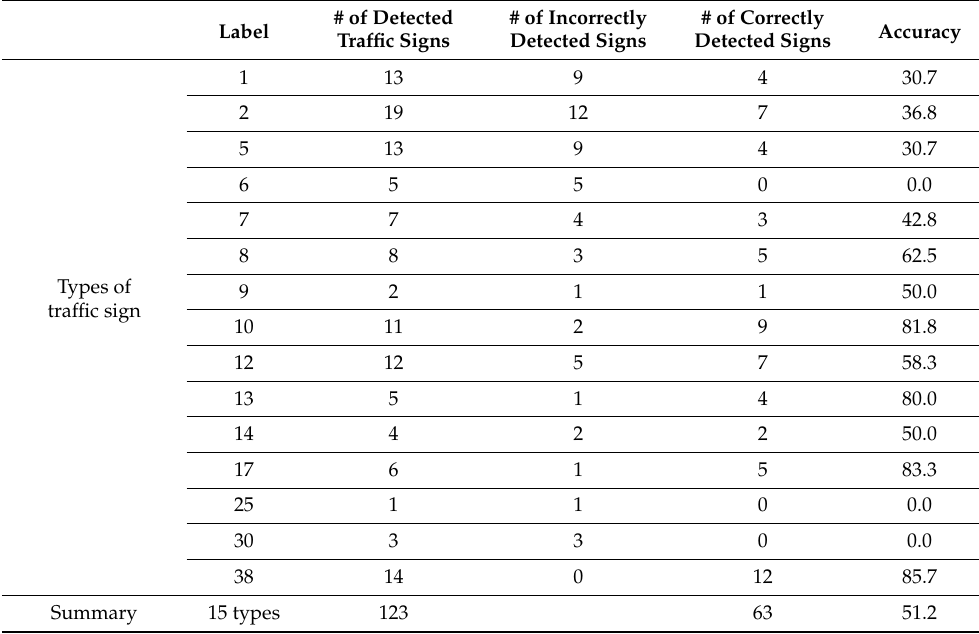
Table 5. Traffic sign recognition results of YOLOv5 using